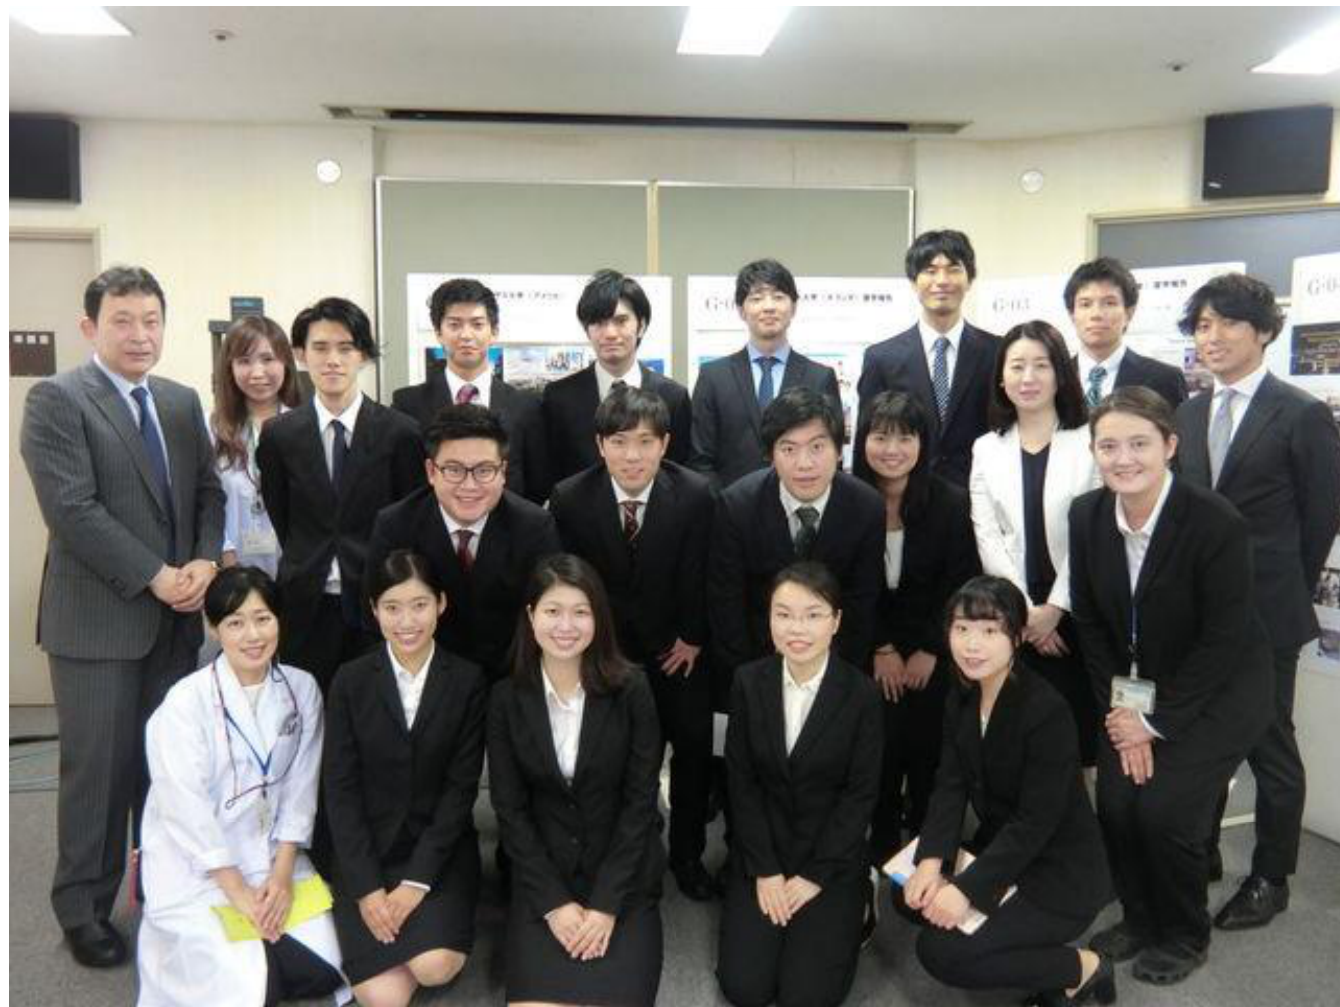
Figure 1. With students who participated in the overseas clinical clerkship and colleagues at Tokyo